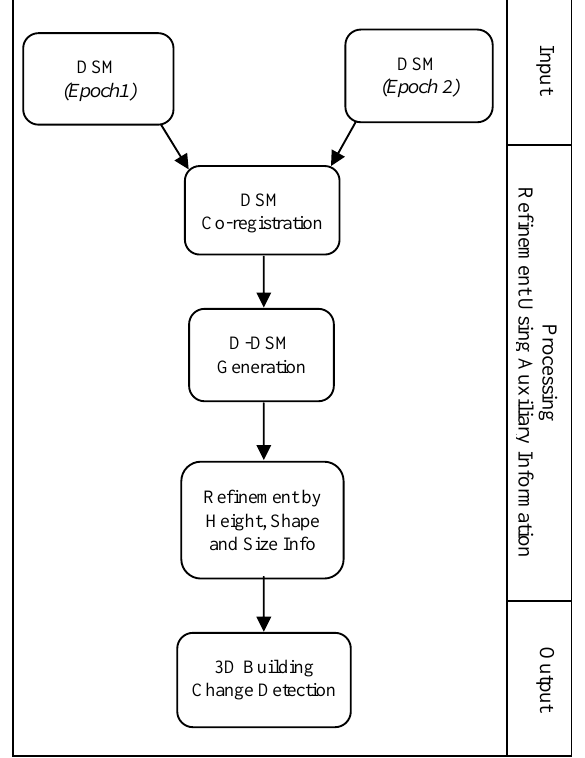
Figure 4. Diagram of 3D building change detection